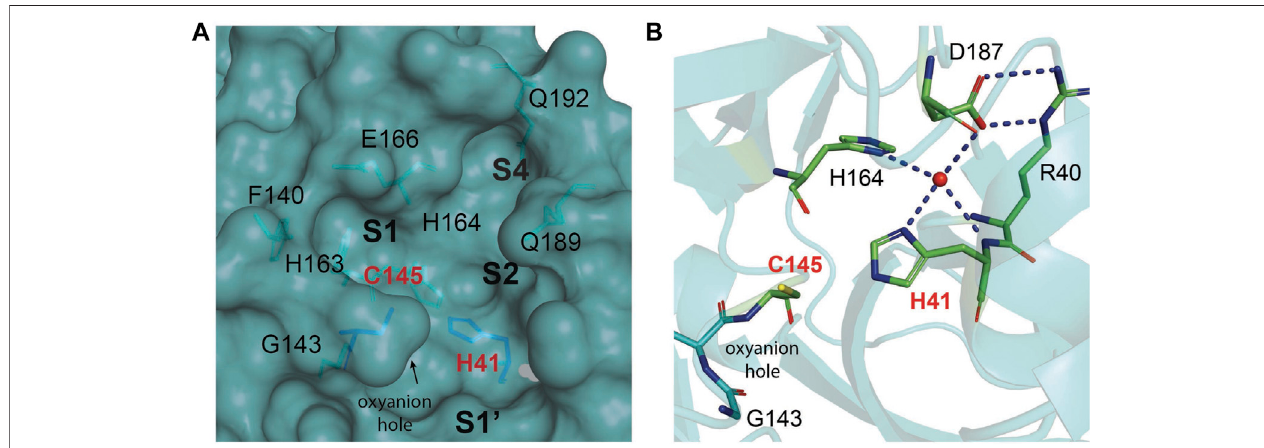
FIGURE9| Thesubstrate-binding cleftlocated betweendomainsIand IIofMpro. (A) Theactivesitecavityislocated onthesurfaceofMpro.Subsites S1,S2,and S4 are shaped into well-formed binding pockets. The catalytic dyad is highlighted in red with the residues that fl ank the cavity. The oxyanion hole created by residues 140 – 144 is highlighted. (B) A close-up view of the catalytic site cavity in which the catalytic residues (Cys145 and His41) are highlighted in red. The catalytic water molecule is shown as a red sphere. Hydrogen bonds are shown as black dashed